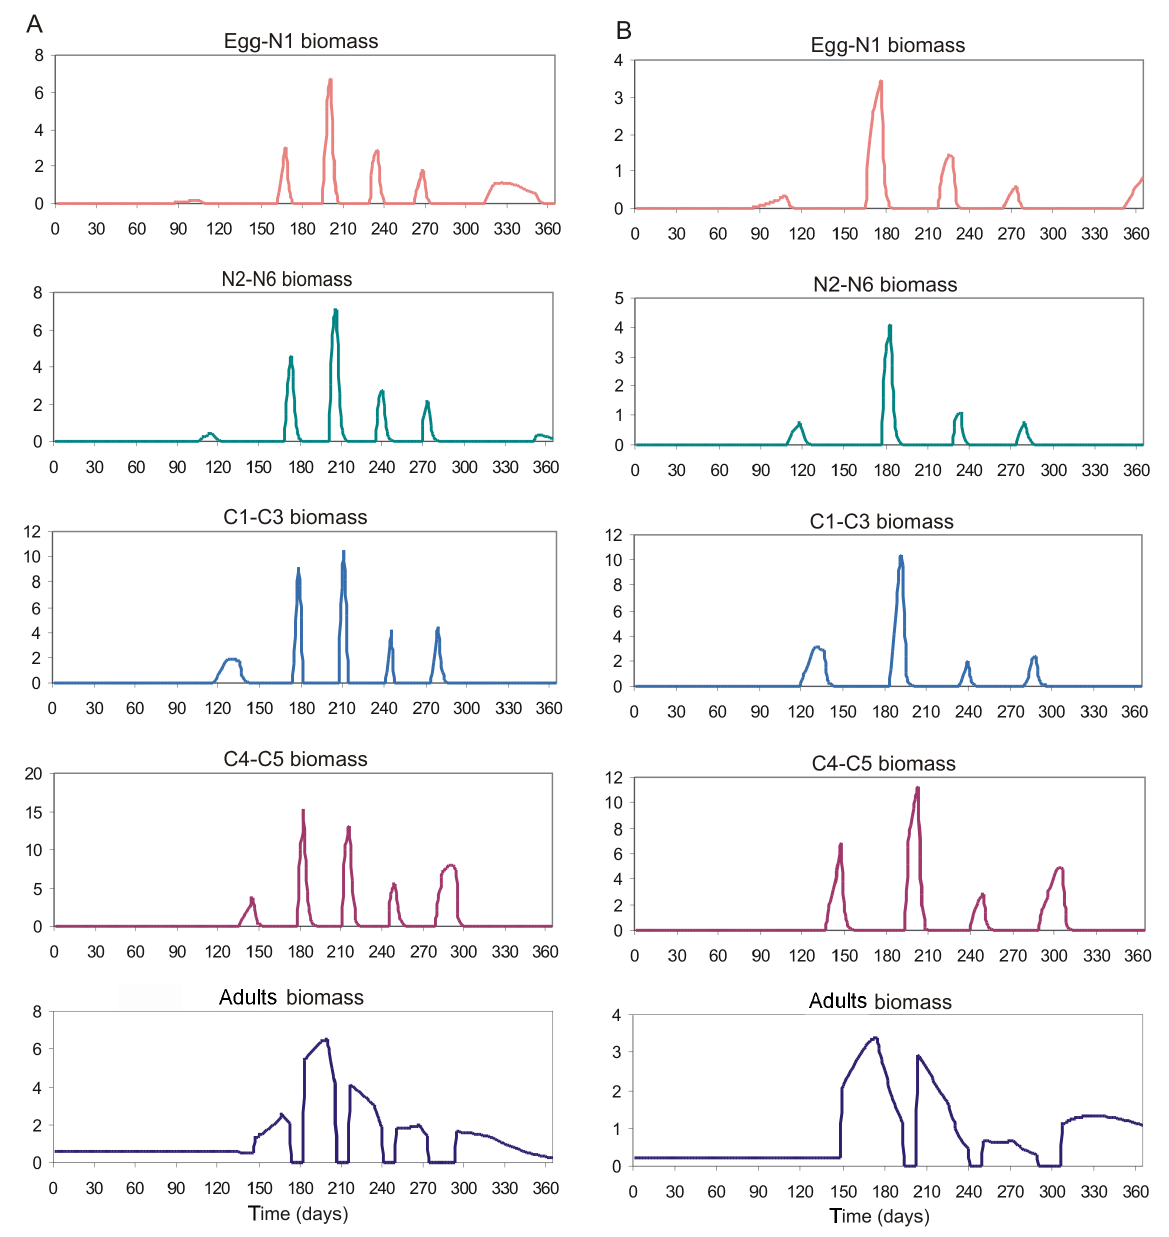
Fig. 4. Stage-specific total biomass (mg C m –3 ) of Temora longicornis simulated for stations P1 – Gda ń sk Deep ( A ) and P2 – Gulf of Gda ń sk ( B ) for the year